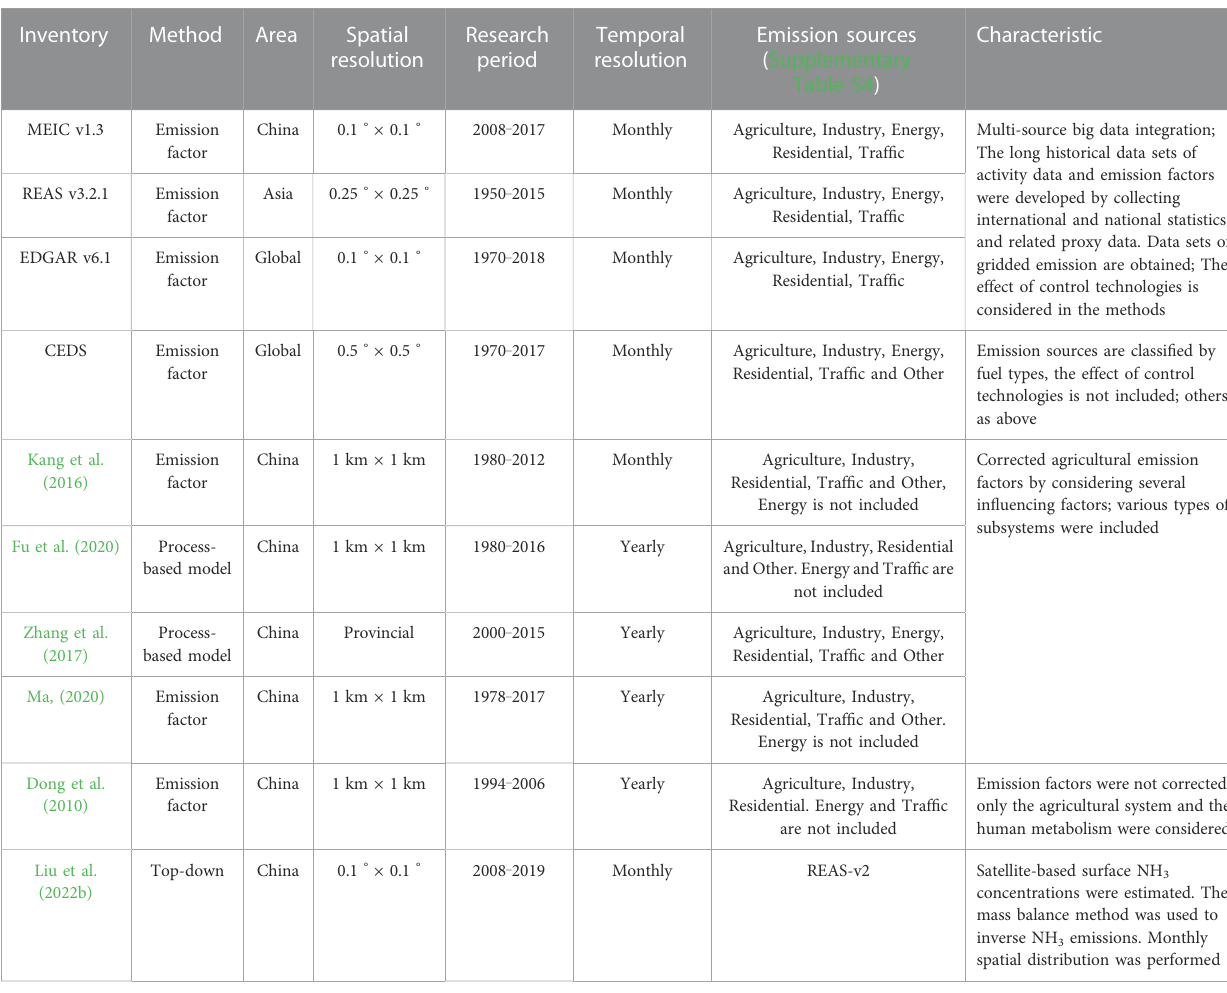
TABLE 1 Summary of the inventories used in this